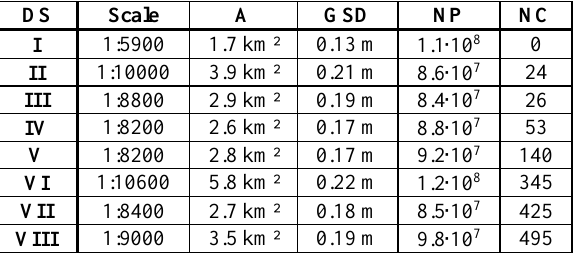
Table 1: Characteristics of the data sets used for evaluation. For an explanation of the abbreviations, see main